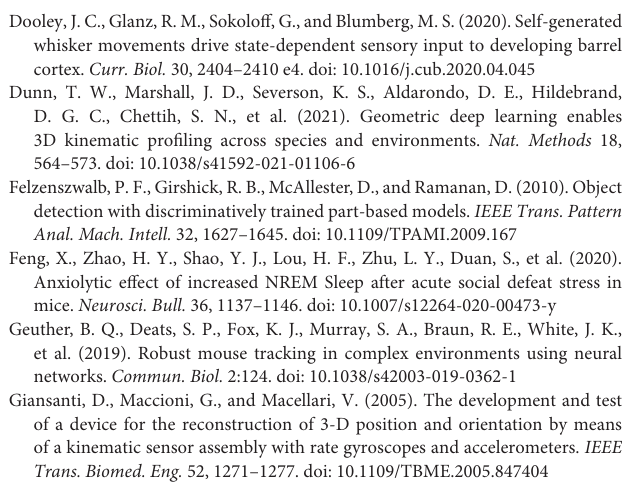
Supplementary Figure 1 | Movement for the mice with different genotypes using DeepBhvTracking. (A) Example imaging showing the movement of a C57BL/6 mice in open field, the center, and corner regions indicated by the different shaded squares. (B) Pseudo heat map showing the animal motion time in (A) . (C) Pseudo heat map showing animal speed in (A) . (D) Comparison of average speed among three genotypes of mice. (E) Comparison of the time spent in the corner and center among three genotypes of mice. (F) Comparison of average speed at the corner and center among three genotypes of mice. ∗ represents p < 0.05, ∗∗ indicates p < 0.01, tested by the ANOVA with LSD test. Supplementary Table 1 | The number of label images were required for detector training of laboratory animal. Supplementary Table 2 | Comparison of tracking time using four tracking methods in different behavior assays. Supplementary Table 3 | Comparison of pixels change per frame using four tracking methods in different behavior assays. Supplementary Table 4 | Comparison of error to ground-truth using four tracking methods in different behavior